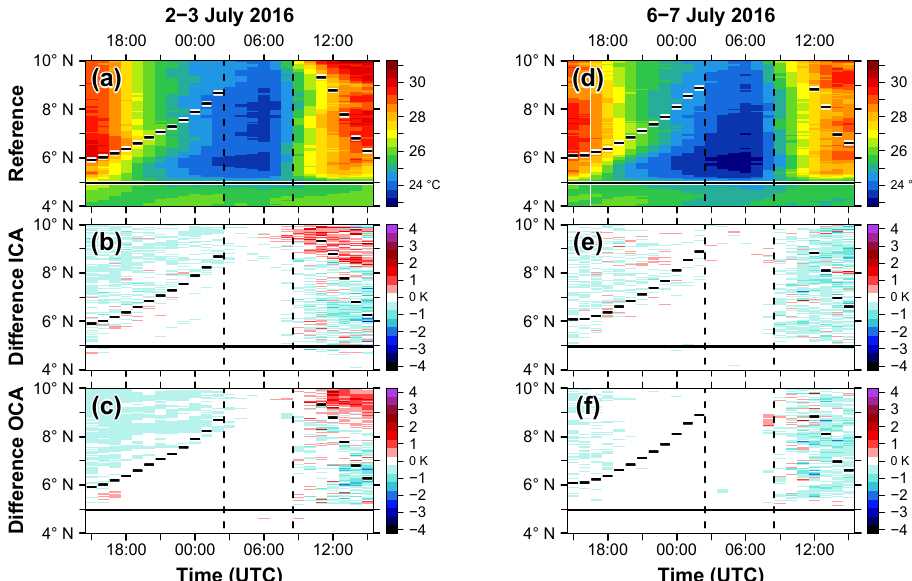
Figure 11. Same as Fig. 9 but for 2m temperature ( ◦ C) and 2m temperature difference (K): (a, c) reference, (b, d) reference minus No-ALWC for ICA and (c, f) reference minus No-ALWC for OCA.